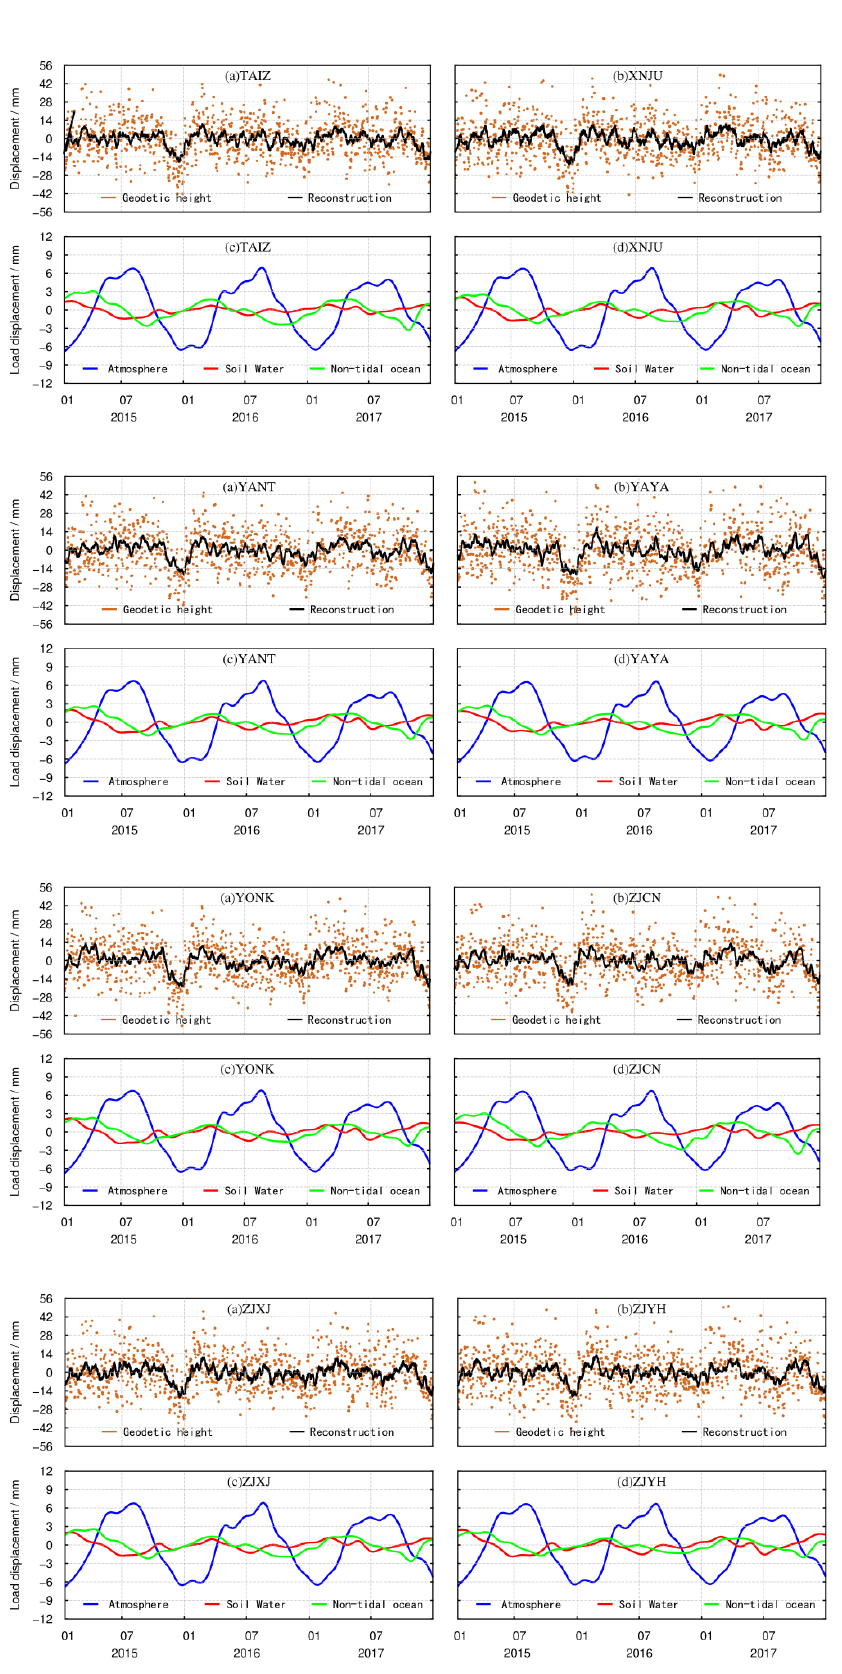
2. Supplement to Figure 6. Figure A1. Supplement to Figure